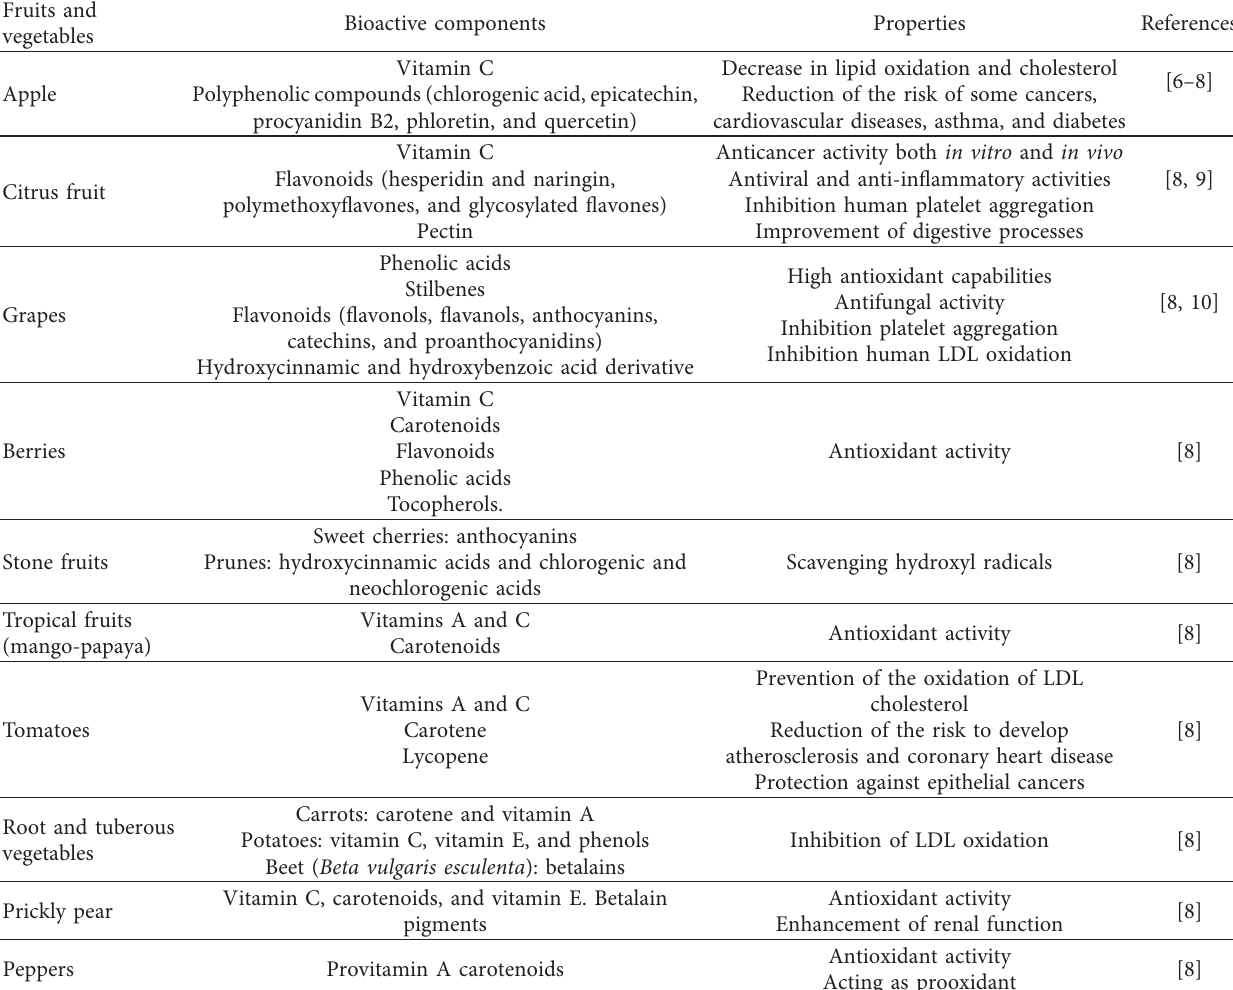
Table 1: The main bioactive components and their properties in some fruits and